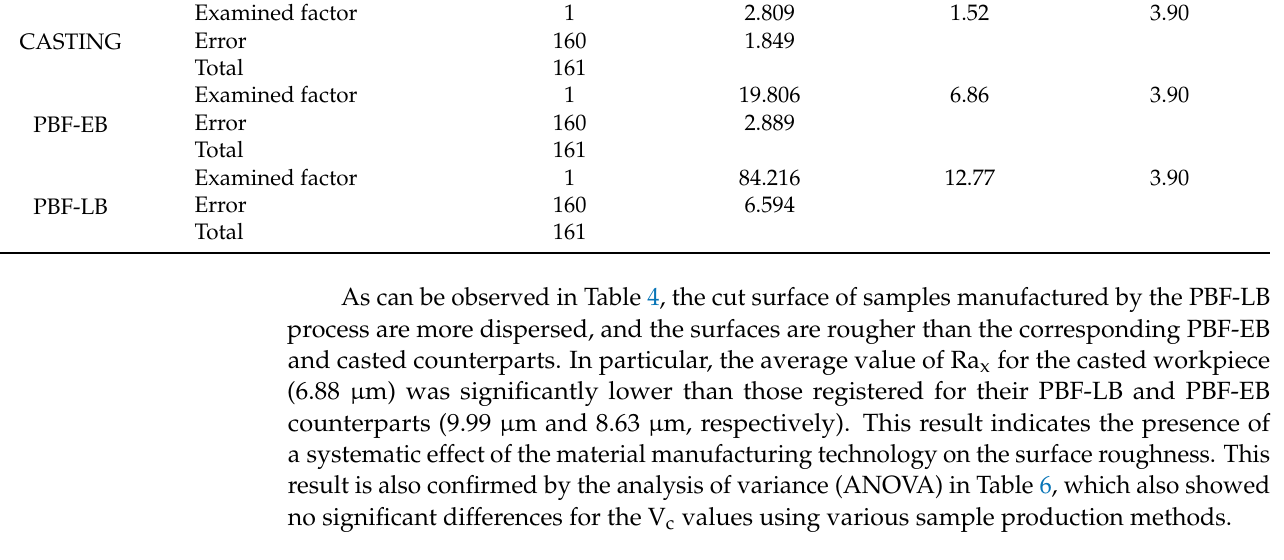
Table 6. ANOVA results for the effect of production technology over cutting speed (V c ) and surface roughness Ra x